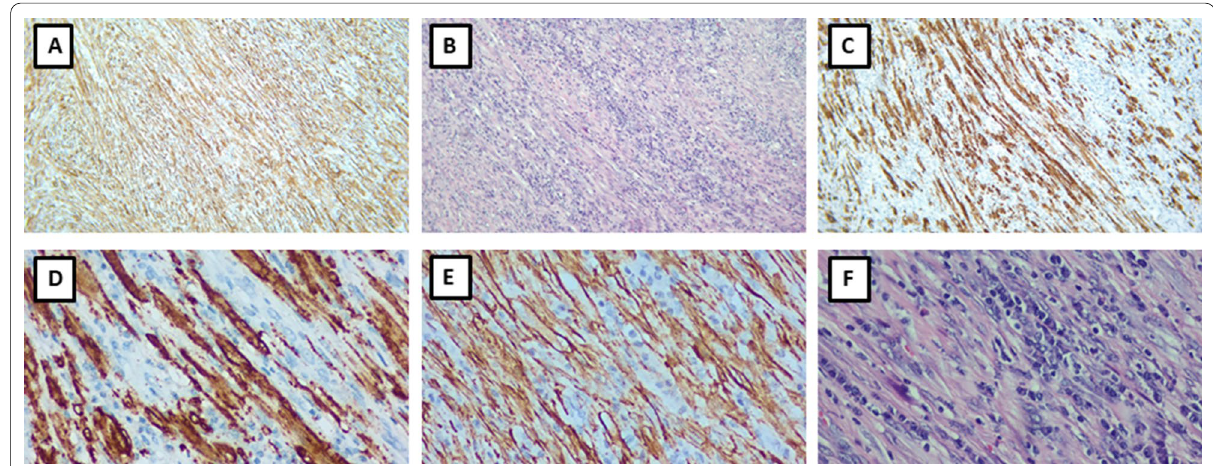
Fig. 2 a , b H&E 10 × –40 × , Histological examination shows spindle cell proliferation with a fascicular pattern admixed with inflammatory cells on